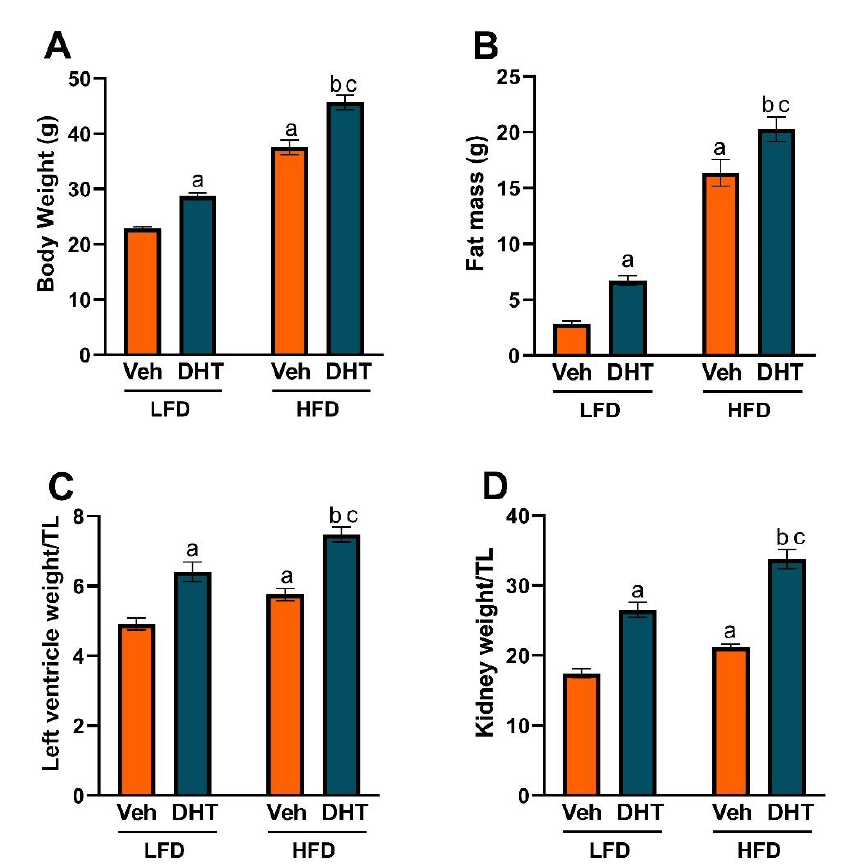
Figure 1. Effect of DHT and diet on body weight and composition, and cardiac and renal hypertrophy. Animals were treated with dihydrotestosterone (DHT) or vehicle (Veh) and maintained in low (LFD) or high (HFD) fat diet for 90 days. ( A ) Body weight was determined by gravimetry. ( B ) Fat mass was determined by EchoMRI. Left ventricle (LV) ( C ) and kidney ( D ) weights were determined by gravimetry and corrected by tibia length (TL). Data are expressed as mean ± SEM. N = 8/group. Data were analyzed by two-way ANOVA followed by Fisher’s LSD test. a p < 0.05 vs. LFD-Veh; b p